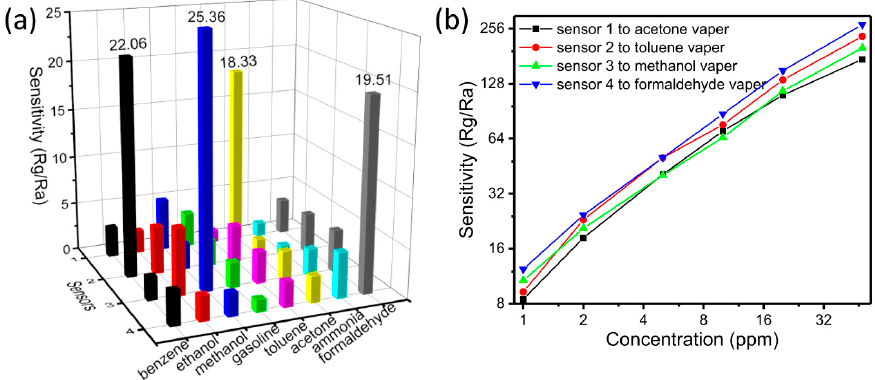
Figure 9. ( a ) The response of each sensor to eight types of analytes (2.5 ppm). ( b ) Response-concentration relationships to the target gases, Sensor 1 is the acetone sensor, sensor 2 is toluene sensor, sensor 3 is methanol sensor and sensor 4 is formaldehyde sensor.